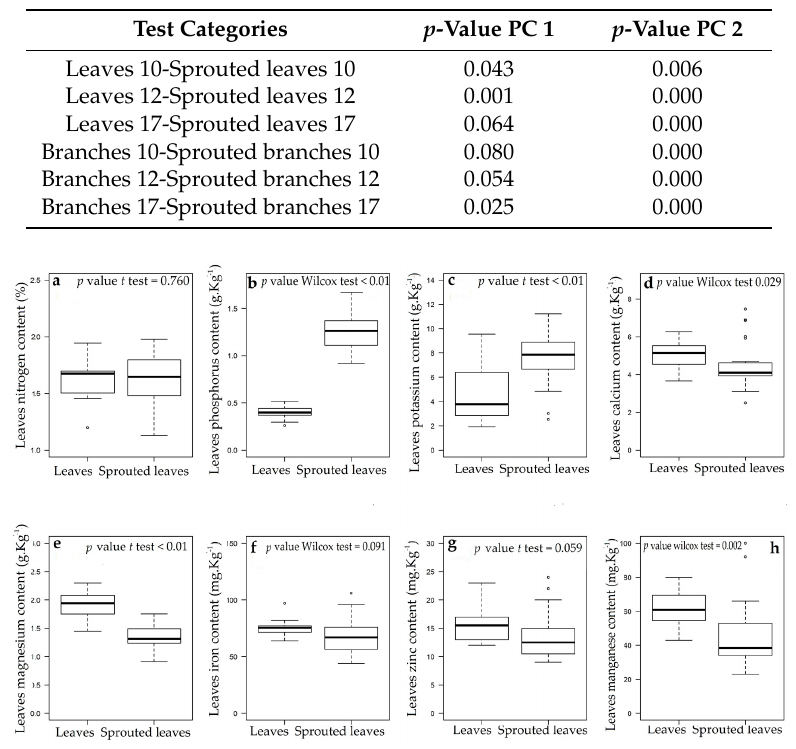
Figure A4. Box plot and p values of paired mean tests comparing leaf chemical attributes data for